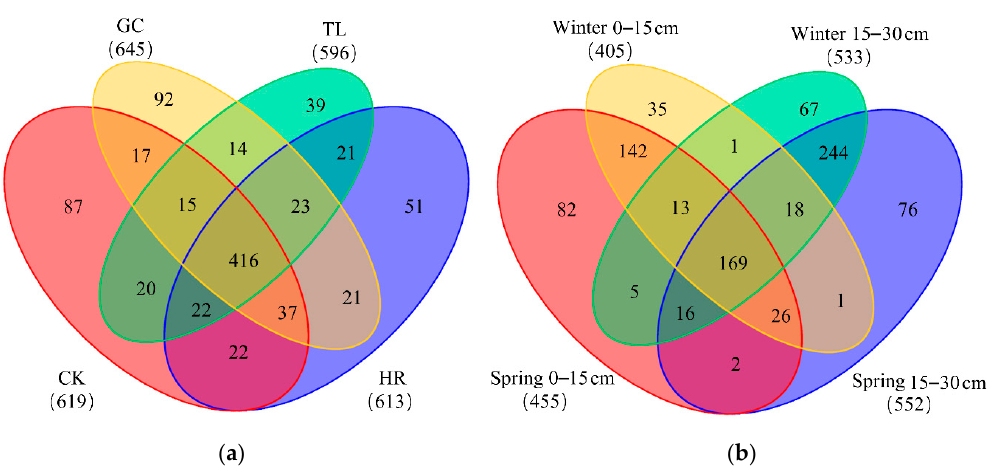
Figure 4. Shared OTUs amongst four sites ( a ) and different seasons and soil depths ( b ). The values in parentheses after each group name indicate the total number of OTUs in the group. Table 2. Mean alpha diversity index values for Arbuscular Mycorrhizal AMF